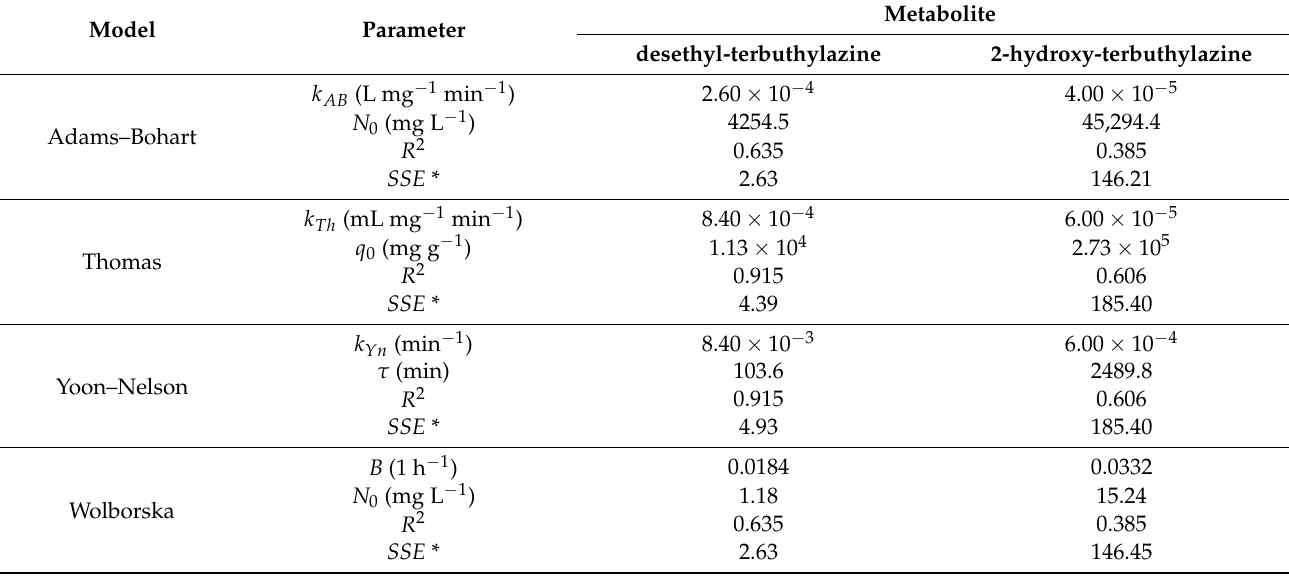
Table 7. Parameters of Adams–Bohart, Thomas, Yoon–Nelson and Wolborska